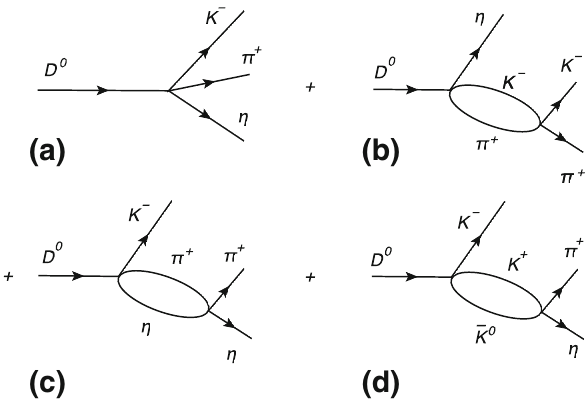
Fig. 3 Final state interaction of the meson